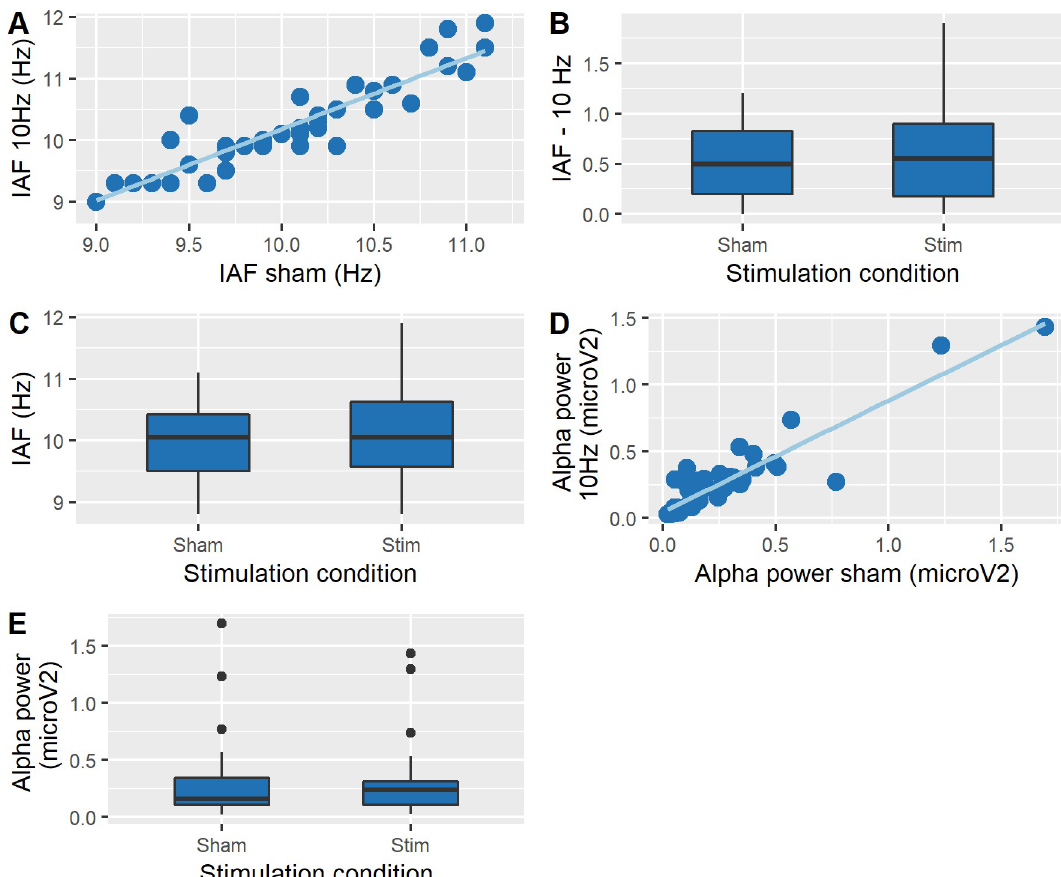
Fig 4. No tACS effects on EEG (eyes closed data). A. Relationship between IAF Stimulation and IAF Sham showing a good test-retest reliability. B. Absolute difference between IAF and 10 Hz during sham and stimulation. There was no significant difference between the two stimulation conditions, indicating there is no evidence for entrainment in our sample (convergence of IAF to 10Hz tACS frequency = zero after tACS relative to sham). C. IAF during sham and stimulation. IAF was slightly (by 0.185 Hz) but significantly increased after tACS relative to sham. D. Relationship between alpha-power Stimulation and alpha-power Sham . E. Alpha power during sham versus stimulation, with no significant difference between the two conditions. All data shown are from electrode O1. The boxplots show a representation of the median and the first and third quartiles. The whiskers of the boxplot can take a maximal value up to 1.5 � interquartile range, with all the values exceeding the whiskers being outliers. Next, we calculated a measure of hemifield bias based on accuracy (Accuracy Left hemifield − Accuracy ) per condition (Fig 5) and examined potential effects of tACS (10 Hz Right hemifield tACS, sham) on this bias measure as a function of cue validity (i.e. invalid, neutral, valid), using a repeated measures ANOVA. In analogy to the analysis on RTs, this did not reveal any significant main effect of tACS condition (F(1,39) = 0.907, p = .346, Z 2 = 0.003), nor an inter- G action with cue validity (F(2, 78) = .336, p = .70, Z 2 = .001), and also no main effect of type of G cue (F(2,78) = 1.272, p = .28, Z 2 = .009). G Effects of tACS on sensations and blinding. After each of the sessions, participants were asked to fill in a questionnaire regarding how well tACS was tolerated. A total of seven different sensations were rated on a scale from 1 (no sensations felt during the experiment) to 5 (strong sensations felt during the experiment). Table 2 shows the average ratings for each of these sensations. At the end of the second session, participants were asked to report in which session they thought they received real stimulation and in which sham. Of the 40